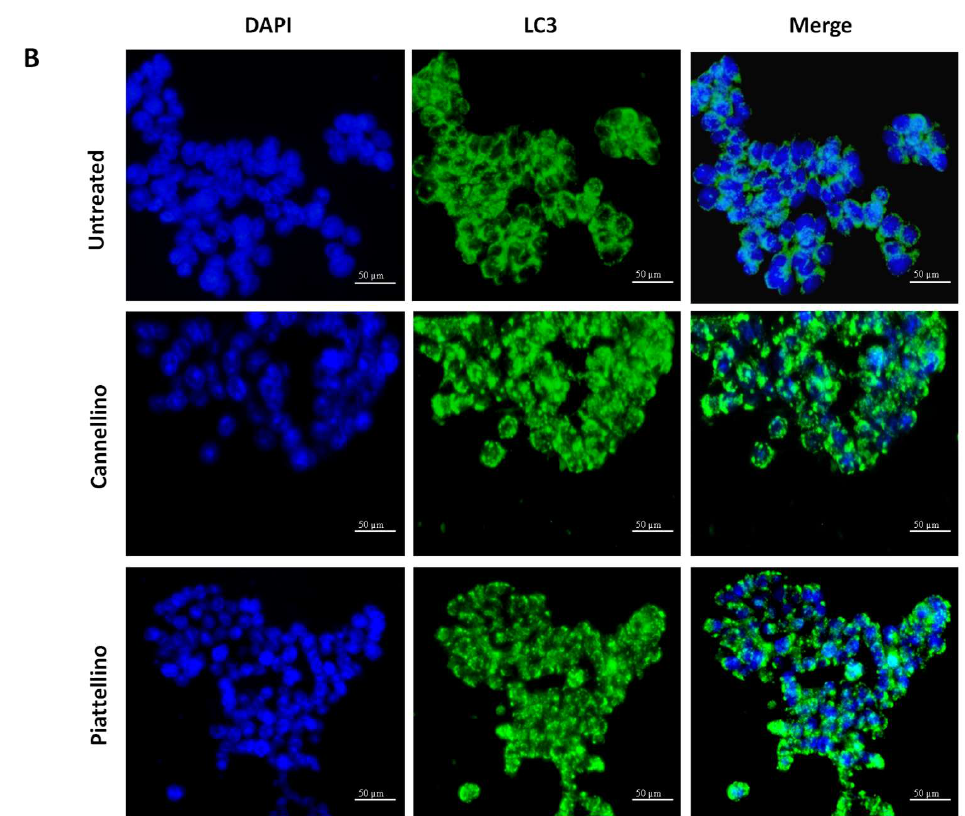
Figure 9. Cannellino and Piattellino BF promotes the activation of autophagy in colon cancer cells. ( A ) HT29 cells were treated with increasing concentrations of BF, and LC3 I and LC3 II were detected through Western blotting. Images are representative of three different experiments. Quantification of bands was performed by ImageJ software. *** p < 0.001, * p < 0.05 vs. basal conditions. ( B ) HT29 cells were seeded on glass coverslips and treated with Cannellino and Piattellino BF (100 μg/mL) for 24 h, fixed, and stained with anti LC3 antibody. Images are representative of two different experiments.